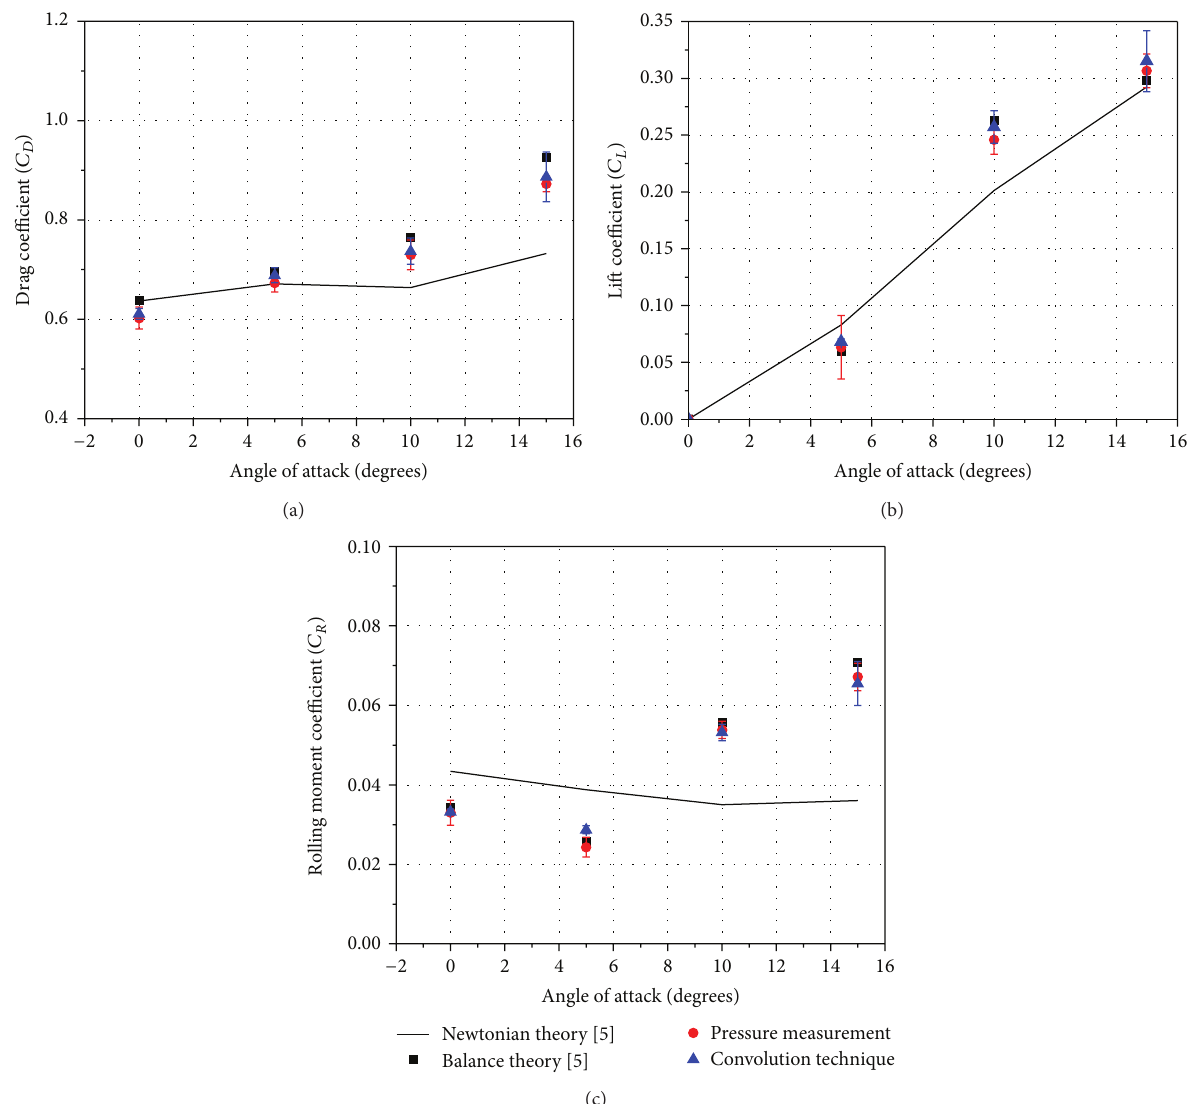
Figure 9: Variation of force and moment coefficients with model AOA. Scatter bars indicate standard